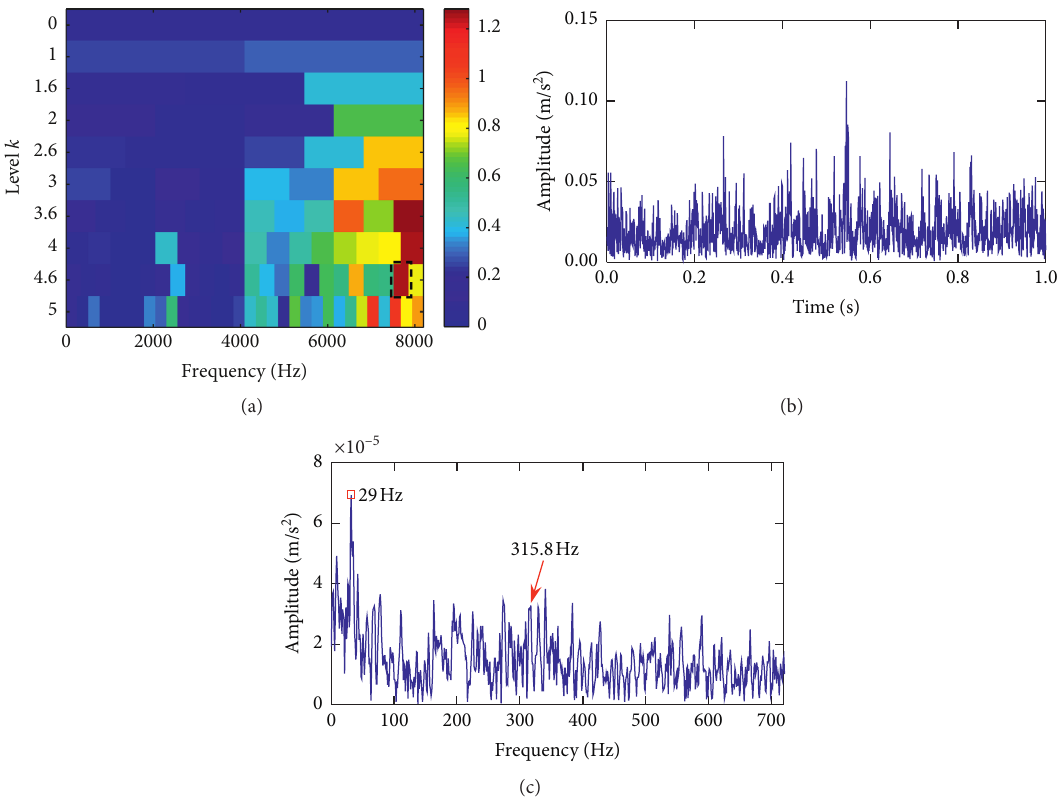
Figure 23: Analysis results of experimental signals by the SK method: (a) fast kurtogram; (b) envelope signal; (c) envelope